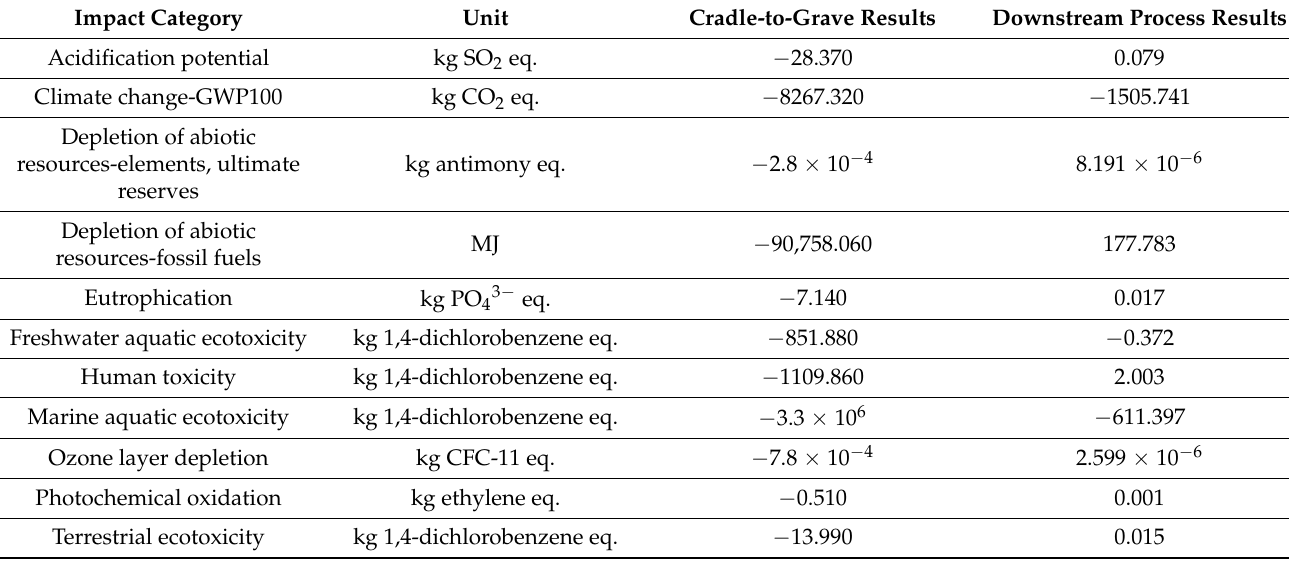
Table 5. CML baseline results (per ton of packed